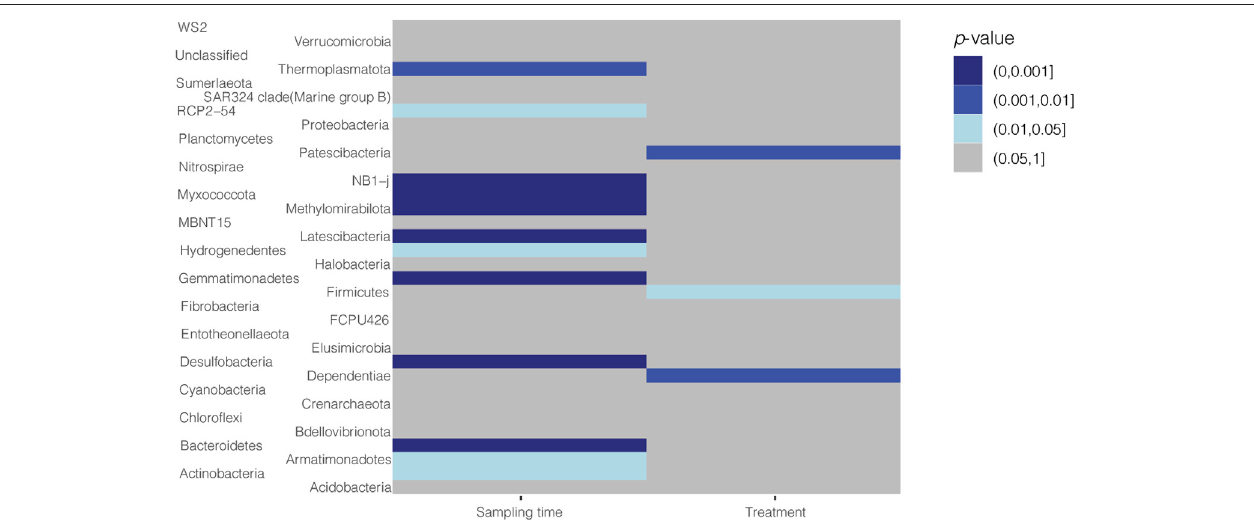
FIGURE 4 | Heatmap for the effects of sampling time and fertilization treatments at the phylum level. Differences in p -values at the phylum taxonomic rank for sampling time or treatment used in samples collected after harvest are indicated in gray (no differences) or different shades of blue ( p -value ranging from 0.05 to 0).